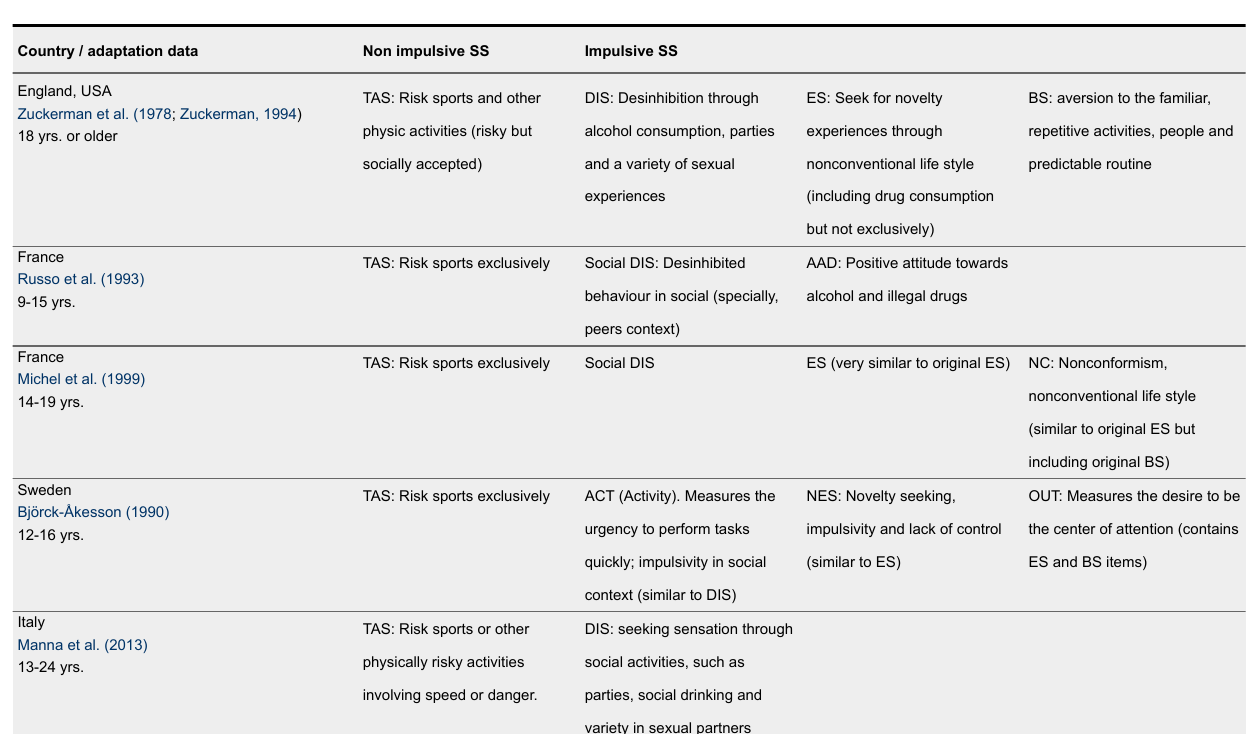
Comparative Table of Different Versions of SSS-V for Adolescents